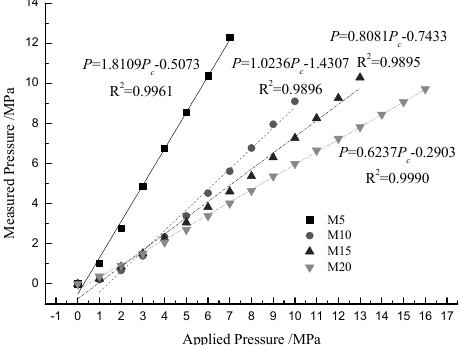
Figure 12. Results of calibration tests.